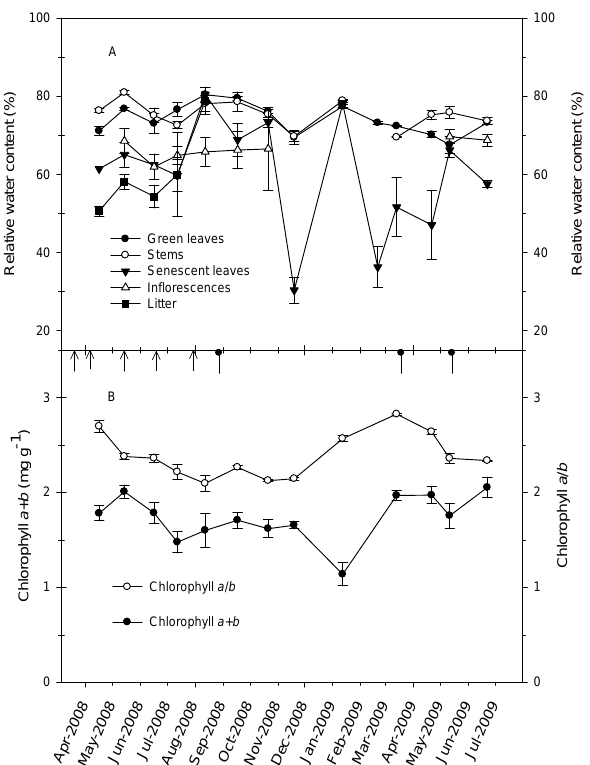
Fig. 3. Seasonal variations in tissue relative water content (A) and leaf chlorophyll and chlorophyll a / b ratio (B) in different tissues of ryegrass. The bar with arrow represents N application as NH 4 NO 3 ; the bar with solid circle represents N application as urea. Values are means ± SE (n=4).